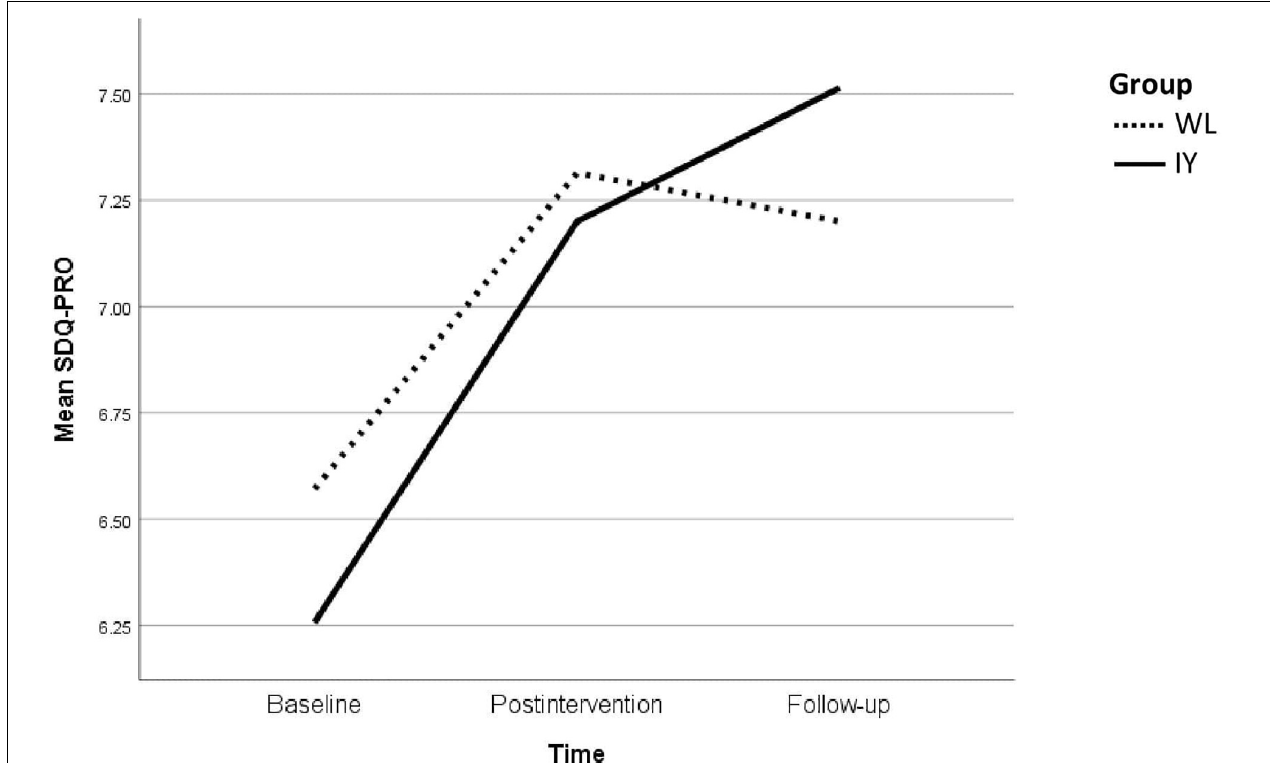
FIGURE 2 | Changes in the prosocial behavior scores (SDQ-PRO) among children in the intervention (IY) and control (WL) group across time.